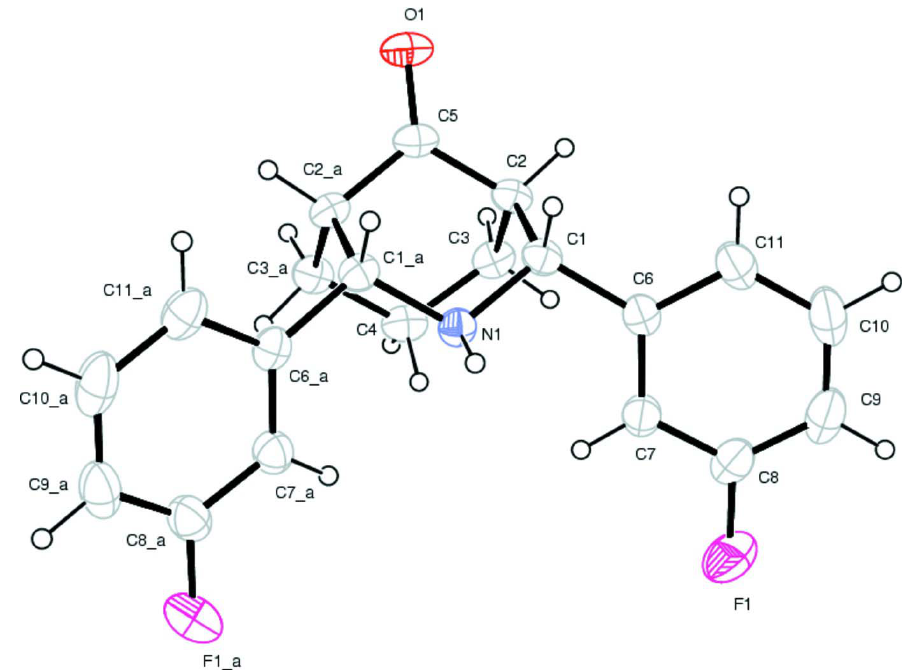
Figure 1 ORTEP of the molecule with atoms represented as 30% probability ellipsoids.[symmetry code: _a: x,1/2-y, z] 2,4-Bis(3-fluorophenyl)-3-azabicyclo[3.3.1]nonan-9-one Crystal